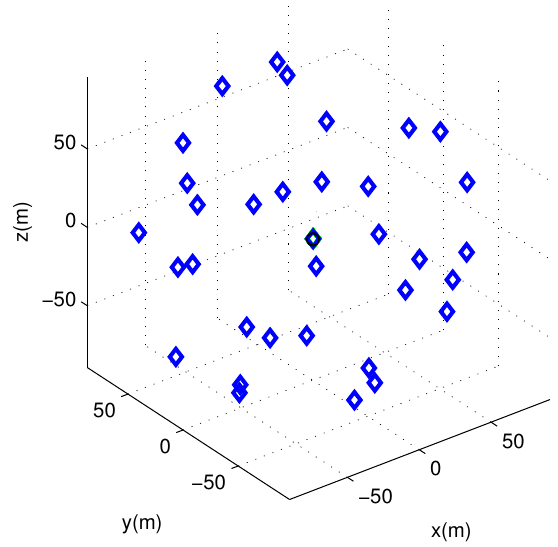
Figure 5. The final position of each AR under our formation controls (Algorithm 1) for covering the user-specified sphere shape. We use r sc = 70